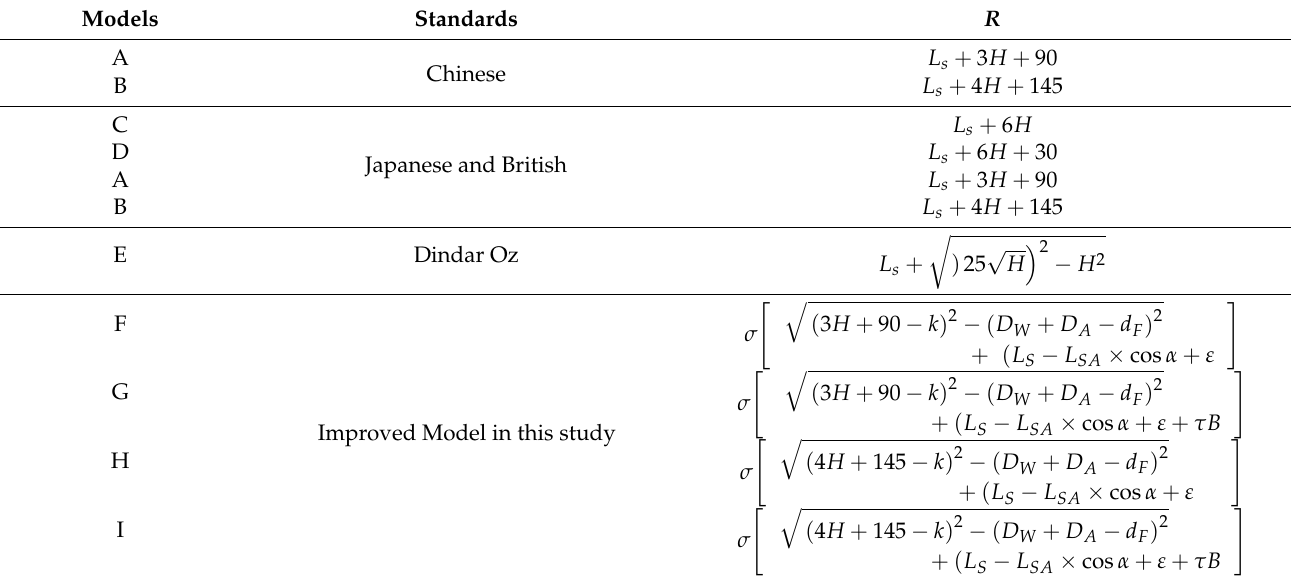
Table 3. Relevant models of anchorage circle radius.